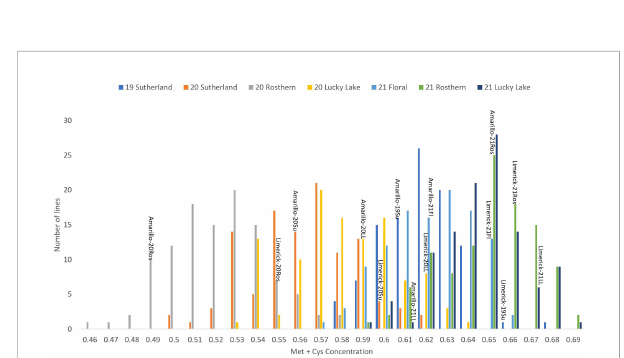
FIGURE 3 Frequency distribution of methionine + cysteine concentration of PR-25 across seven station-years based on the average of biological replicates for each line in each station-year (two biological replicates in 2019 Sutherland and three biological replicates for the rest of the station-years), and the averaged methionine + cysteine concentration for the parents of PR-25 in each